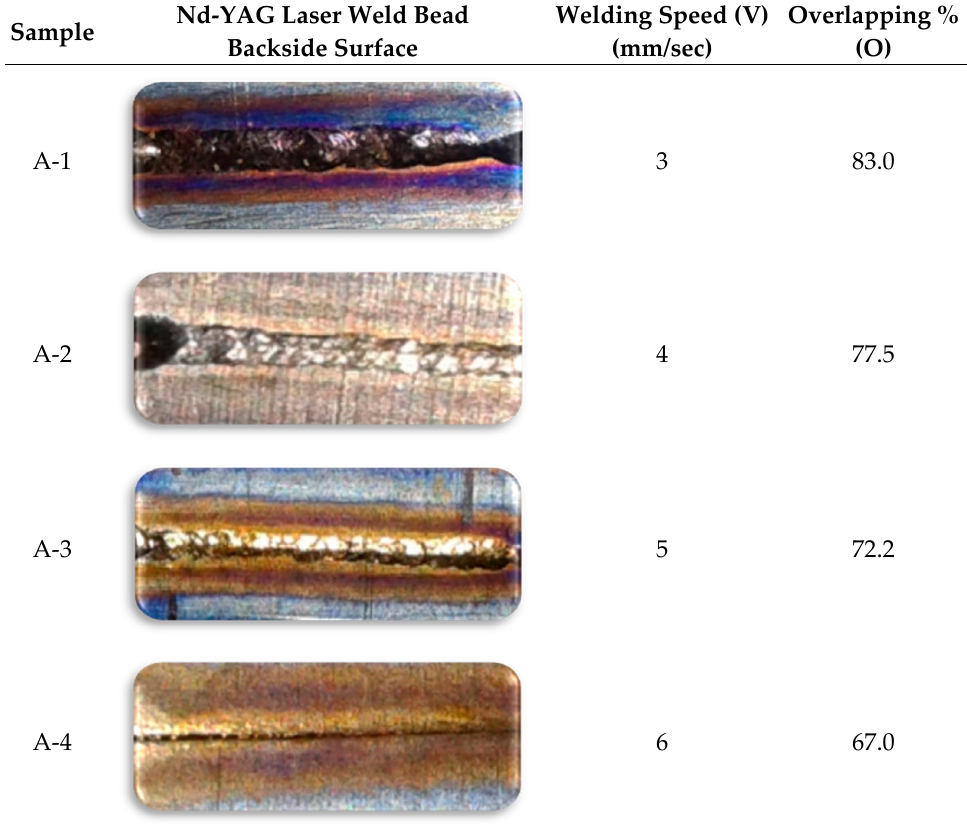
Figure 4. Images of the weld bead backside face with different overlapping percentages and welding speeds with a magnification scale of 50 × .